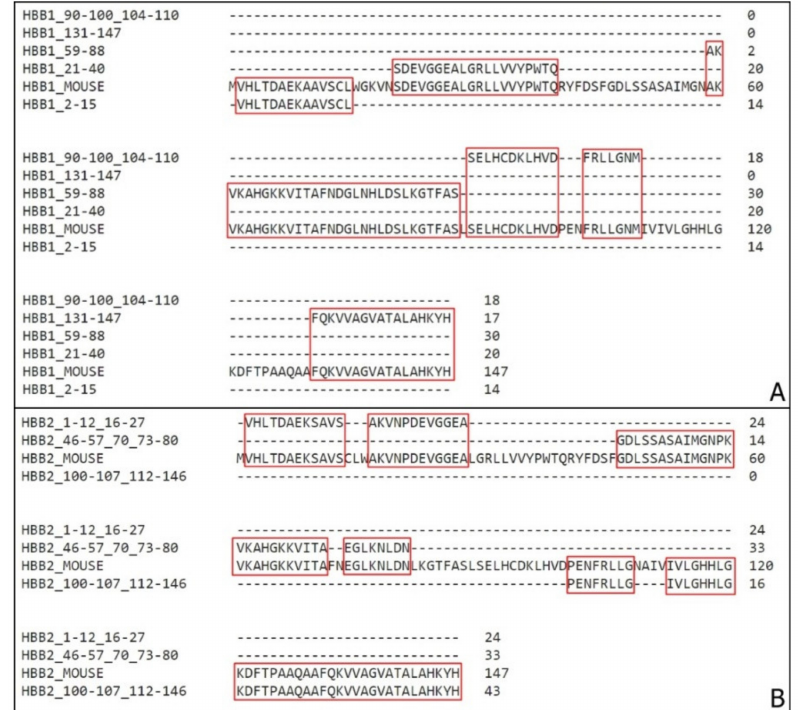
Figure 3. Coverage of Mus musculus β hemoglobin sequence. ( A ) Alignment of the fragments obtained through mass spectrometry with the mouse hemoglobin β 1 chain (HBB1). ( B ) Alignment of the fragments obtained through mass spectrometry with the mouse hemoglobin β 2 chain (HBB2). Sequences compilation was performed to avoid residues repetitions. Highlighted in red are the residues coverage. Table 4. Sequences with highest score. On the hemoglobin α chain, three fragments are the most confident sequence. Fraction A1 (eluted at 24.8 min) has the fragment from the amino acid 2 to 10, Fraction A2 (eluted at 64.5 min) and Fraction A3 (eluted at 81.8 min) have the fragment from the amino acid 77 to 95. On the hemoglobin β chain, the most confident sequence on the Fraction B1 (eluted at 28.28 min) is the fragments from the amino acid 2 to 10, on the Fraction B2 (eluted at 35.5 min) is the fragment from the amino acid 1 to 10, on the Fraction B3 (eluted at 43 min) is the fragments 1–12, 58–72 and 112–129 of the hemoglobin β chain. Fraction B4 (eluted at 48.1 min) has three peptides corresponding to the fragments 2–14, 59–88 and 135–147 of the hemoglobin β chain. Fraction B5 (eluted at 56.4min) has four peptides corresponding to the fragments 34–40, 59–71, 75–86 and 90–100 of